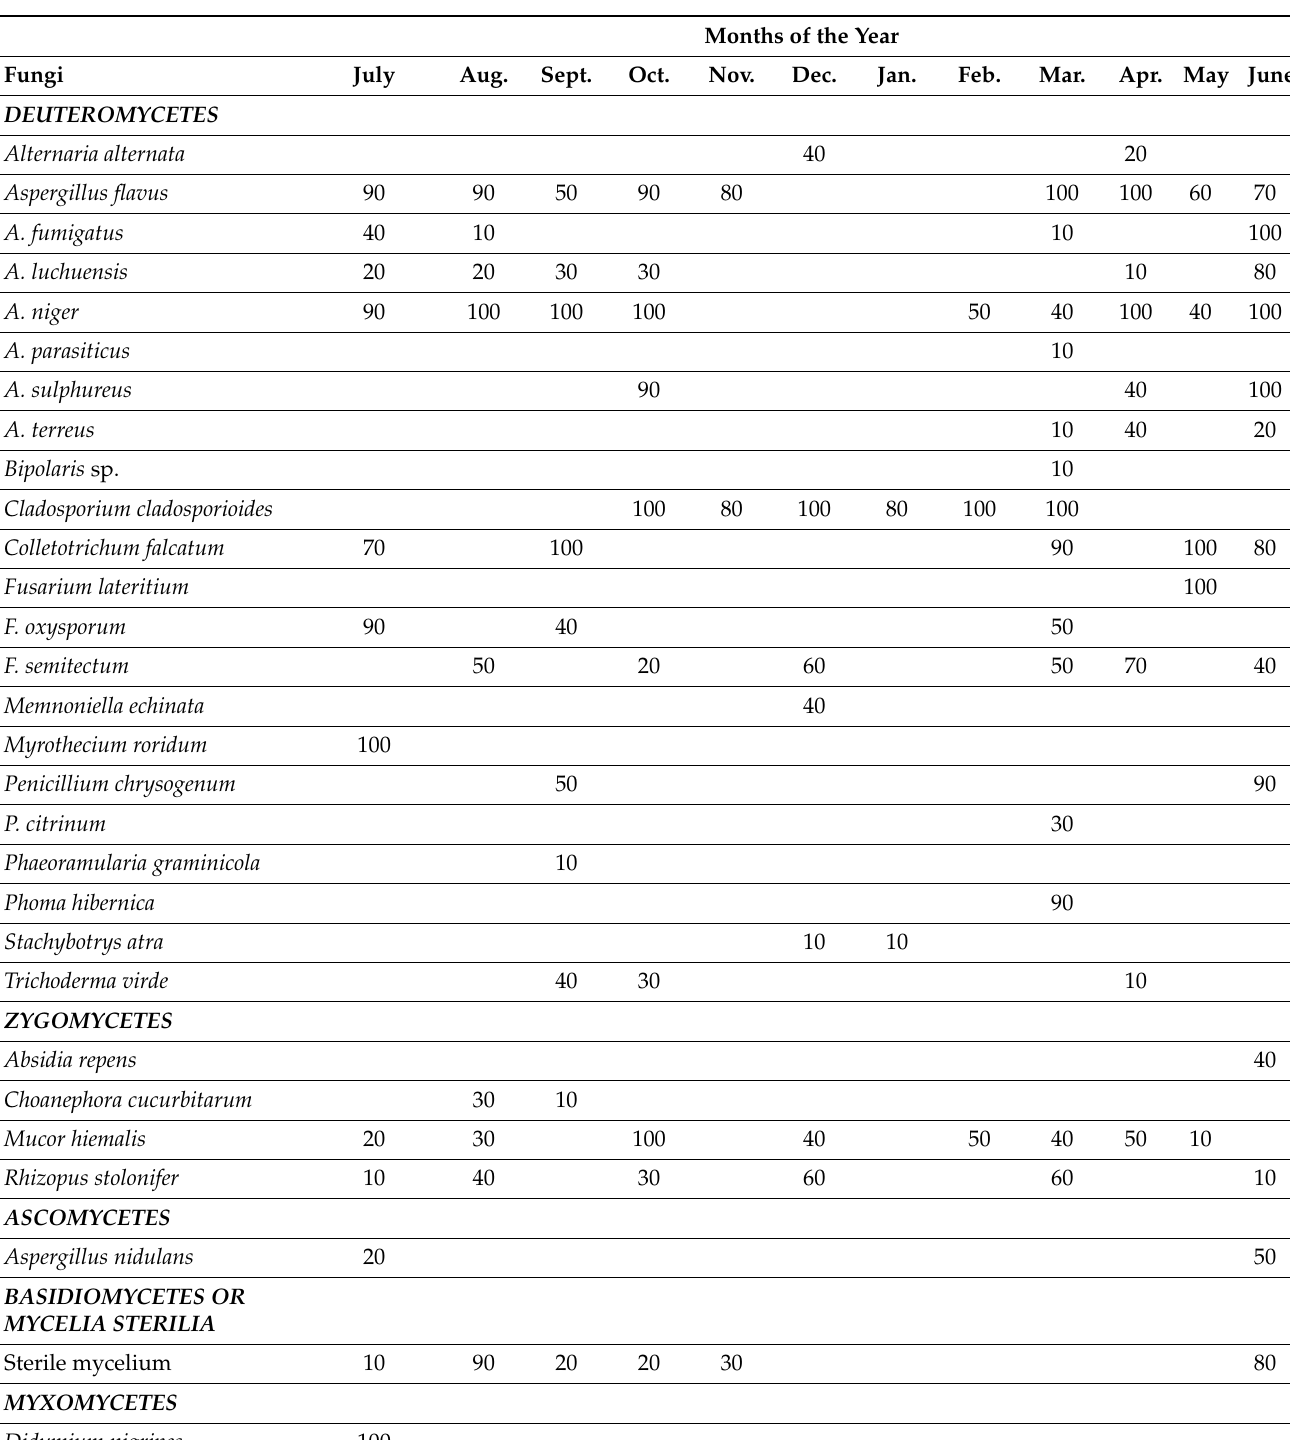
Table 6. Percentage frequency of occurrence of various fungi on completely decomposed leaves